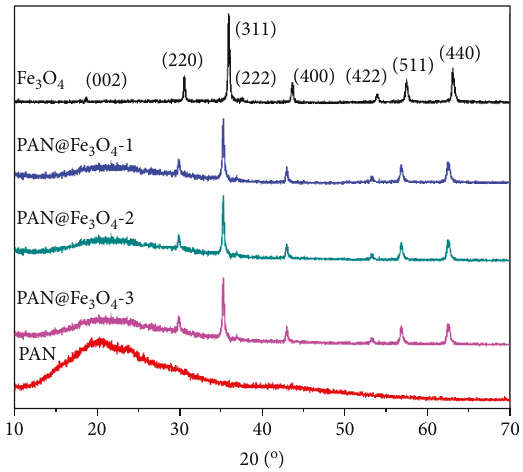
Figure 3: XRD pattern of Fe PAN@Fe